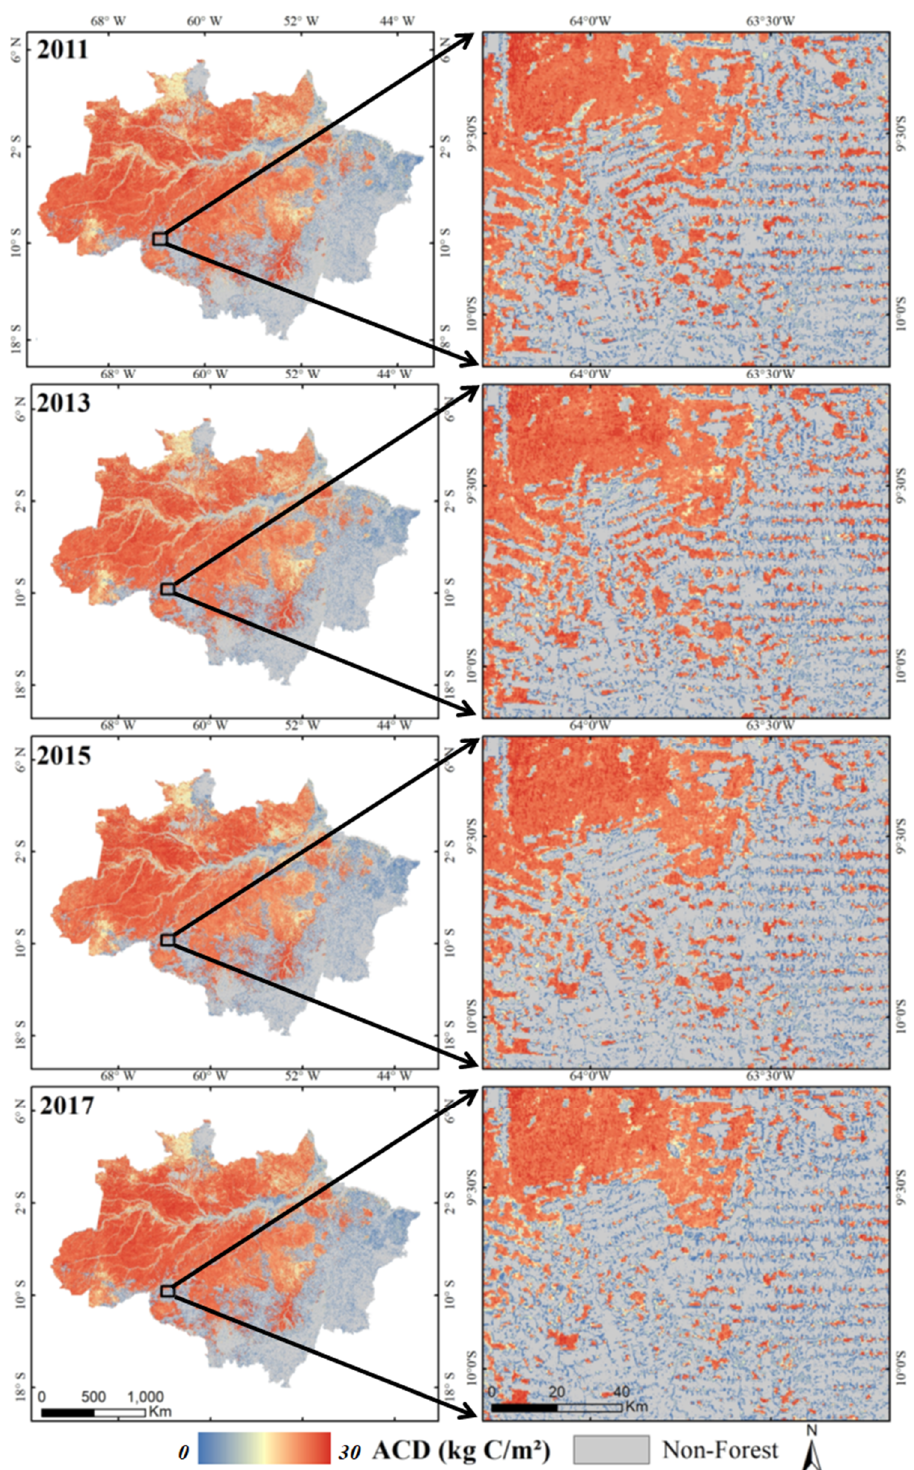
Figure 6. Spatial distribution of aboveground carbon density (ACD) estimation using the random forest approach for 2011–2017.